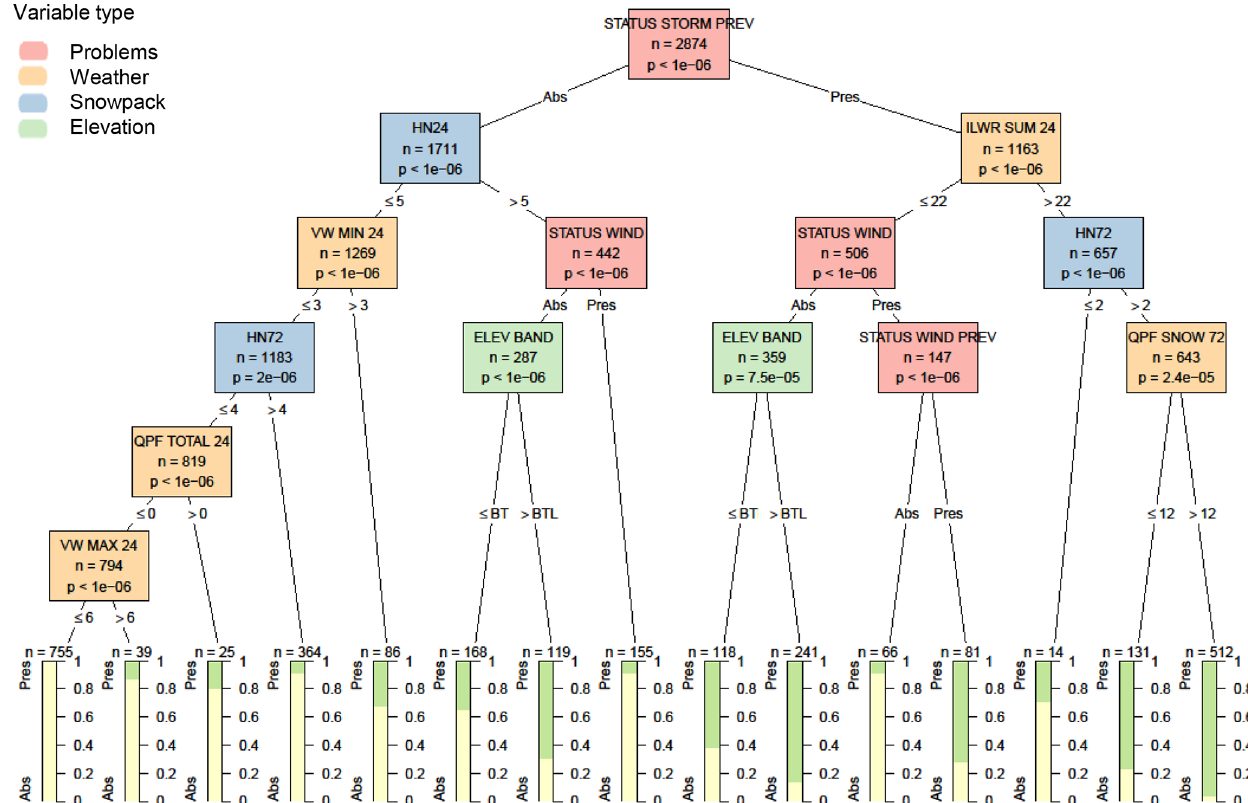
Figure 6. Decision tree for the presence or absence (Pres/Abs) of storm slab avalanche problems based on weather, snowpack, and contextual variables about the hazard assessment. Variables appearing in the tree include the presence or absence of a storm slab problem the previous day (STATUS STORM PREV), the height of snow in the past 24h incm (HN24), minimum hourly wind speed over the past 24h in ms − 1 (VW MIN 24), the total amount of precipitation in the past 24h in mm (QPF TOTAL 24), the maximum hourly wind speed over the past 24h in ms − 1 (VW MAX 24), the presence or absence of a wind slab problem the same or previous day (STATUS WIND and STATUS WIND PREV), elevation band (ELEV BAND) relative to below the treeline (BTL), the total incoming longwave radiation accumulated over the past 24h in MJm − 2 (ILWR SUM 24), and the total amount of solid precipitation over the past 72h in mm (QPF SNOW 72). Terminal nodes show the proportion of cases with storm slab problems present (green) and absent